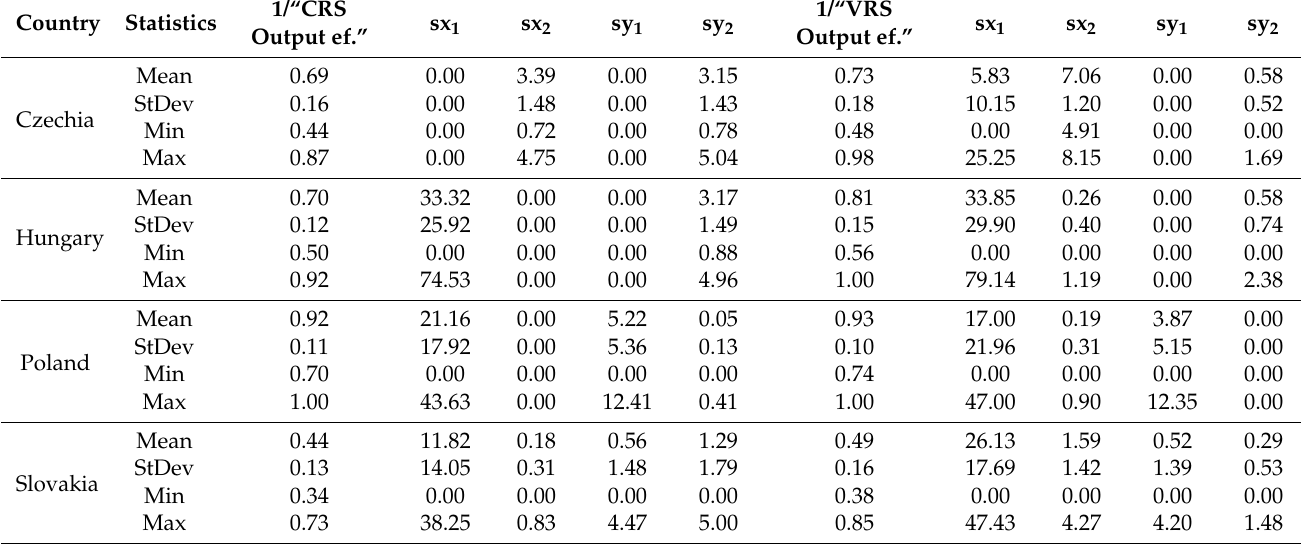
Table 4. Results of DEA, CRS and VRS efficiencies of V4 group.